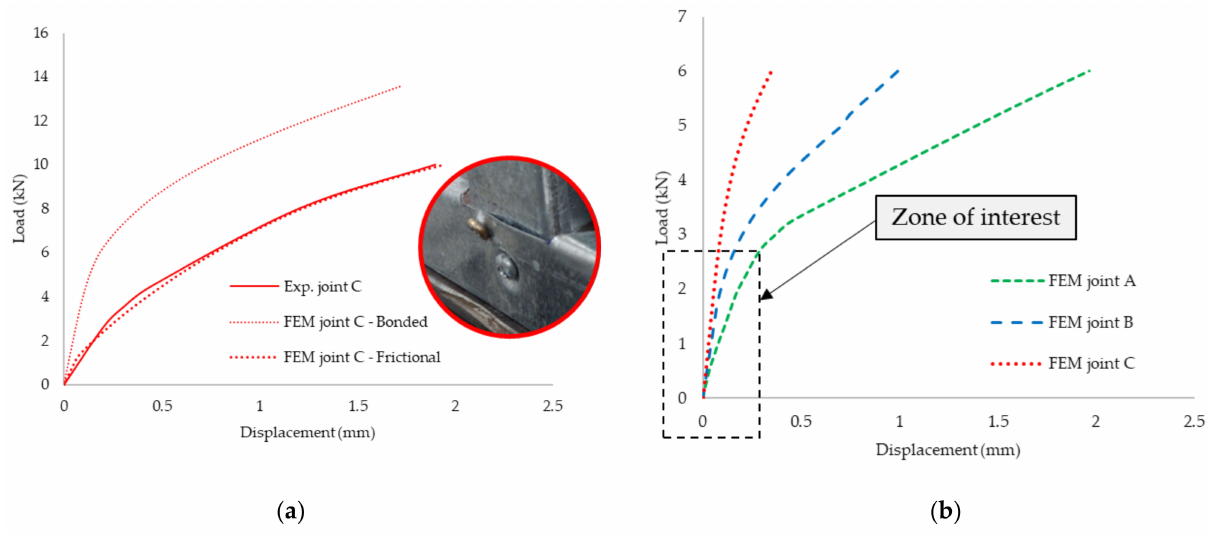
Figure 38. Comparative load–displacement curves: ( a ) Joint C; ( b ) FE